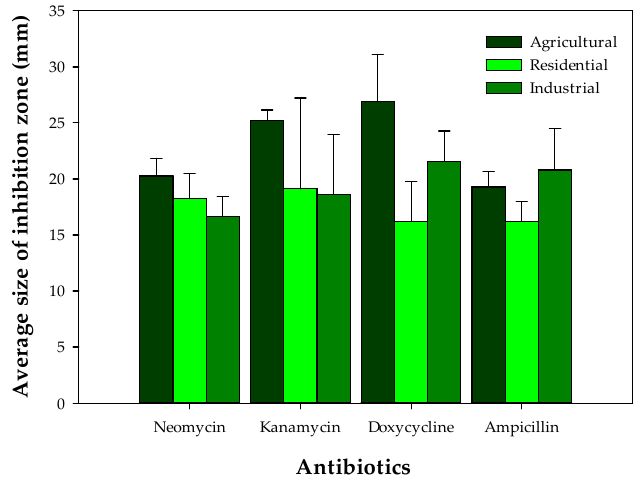
Figure 3. Effect of different antibiotics on bacterial candidates isolated AC filters from different sampling sites.